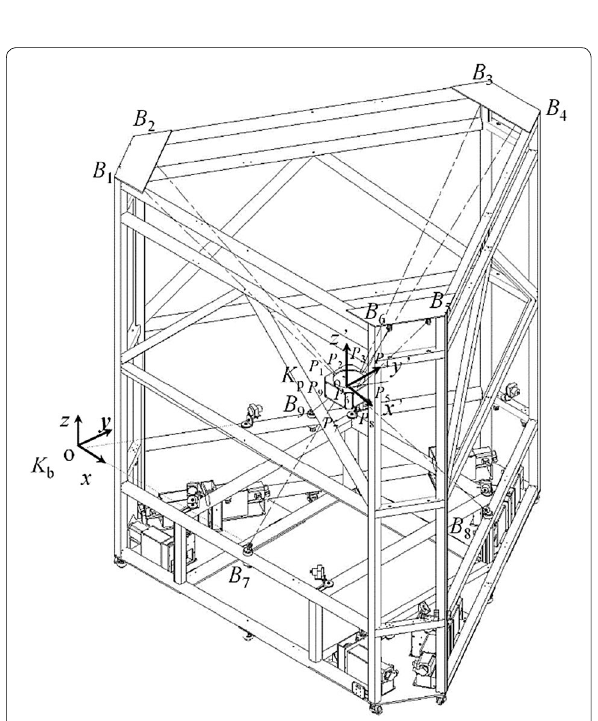
Figure 2 Mechanism